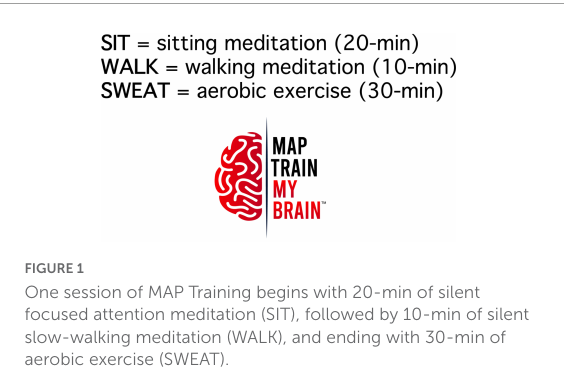
defined as lying between 60 and 80% of participants’ maximum which is calculated by subtracting their age from 220. For most participants, their aerobic range was greater than 90 beats per minute but less than